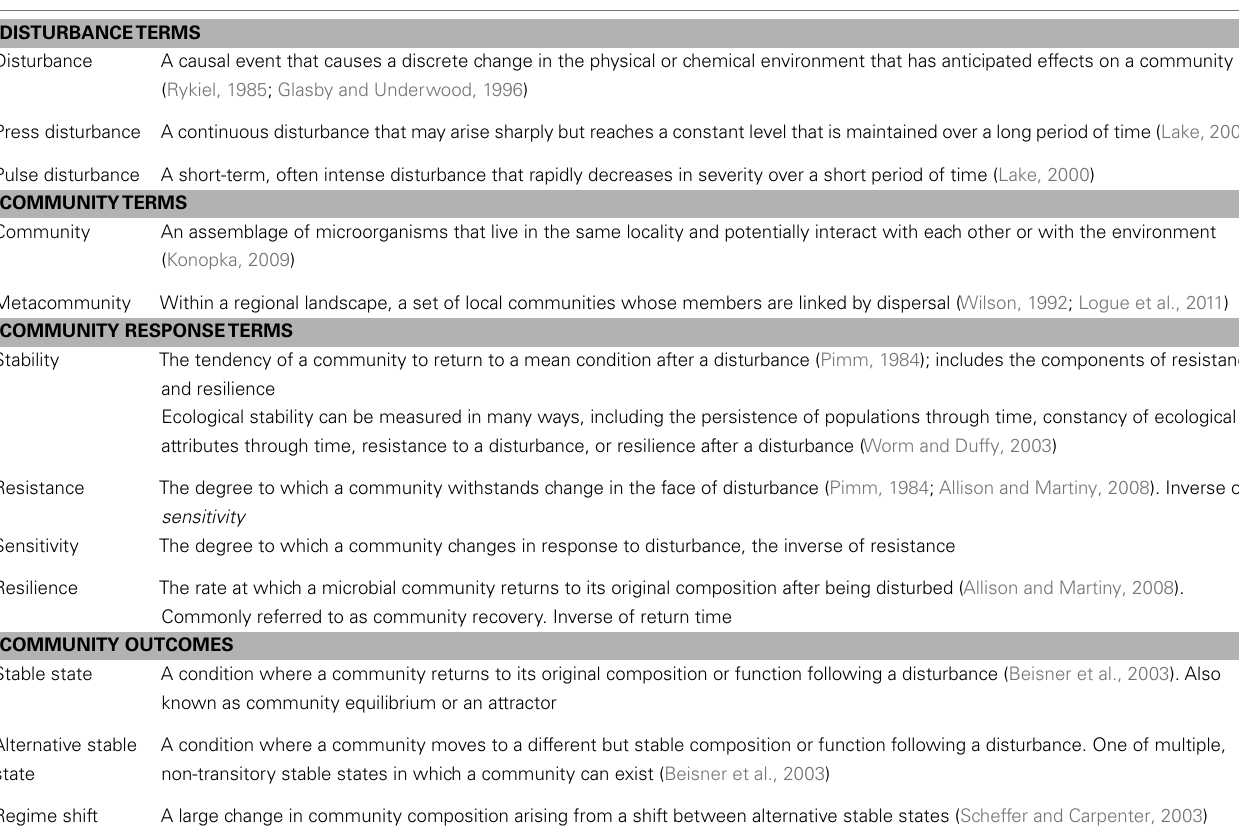
Table 1 | Common terms for disturbances, community responses, and community